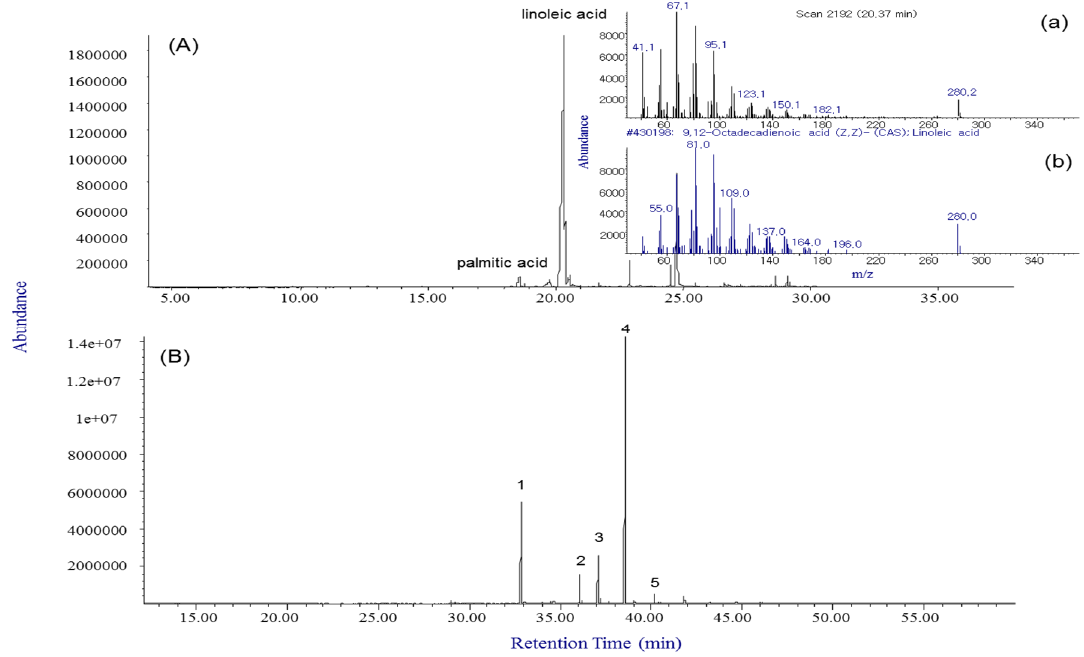
Figure 5. Typical total ion chromatograms obtained from the lipid phase of Xanthii Fructus samples without esterification ( A ) (the major peak at t R = 20.37 ( a ) was identified by consultation with the Wiley7n EI mass spectral library ( b )) and after the esterification procedure ( B ). Numbered peaks were identified as follows: 1. cis-10-pentadecanoic acid (C15:1), 2. cis-10-heptadecenoic acid (C17:1), 3. elaidic acid (C18:1n9t), 4. linolelaidic acid (C18:2n6t), and 5. cis-11,14-eicosadienoic acid (C20:2).